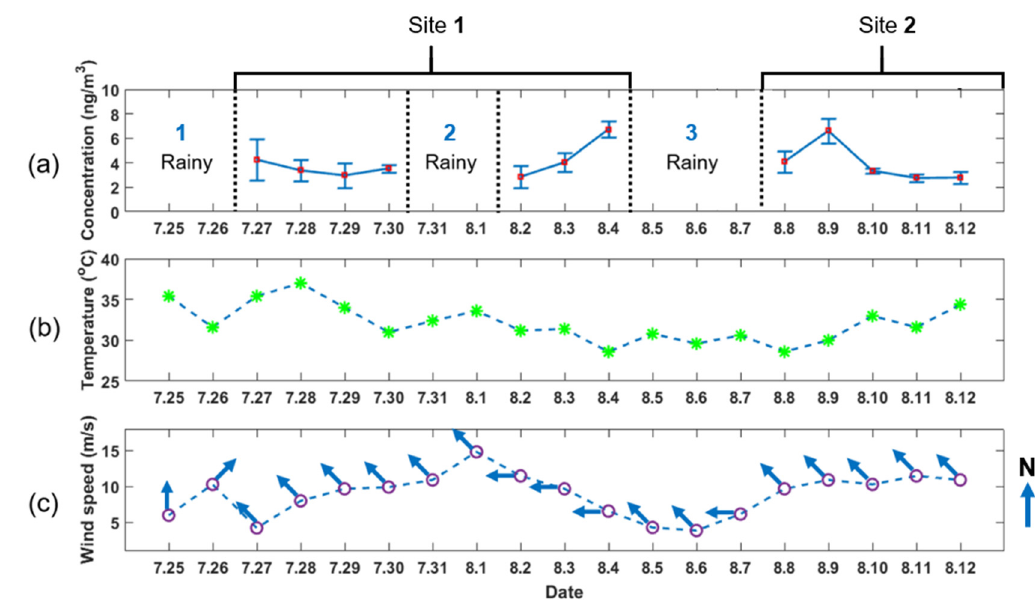
Figure 6. ( a ) Mercury average concentration in the Qin mausoleum area during a period with weather changes; ( b ) temperature change and ( c ) wind speed variance during the monitoring period; the blue arrows in ( c ) indicate the wind direction. Weather data are from the local Lintong weather service.